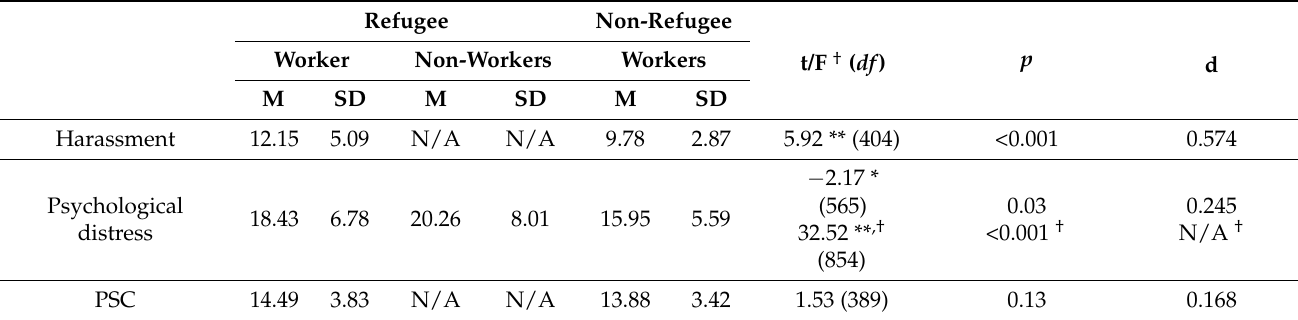
Table 2. T -tests and one-way ANOVA for comparing refugee workers, refugee non-workers and non-refugee workers (AWB) on levels of psychological distress, harassment, and Psychological Safety Climate